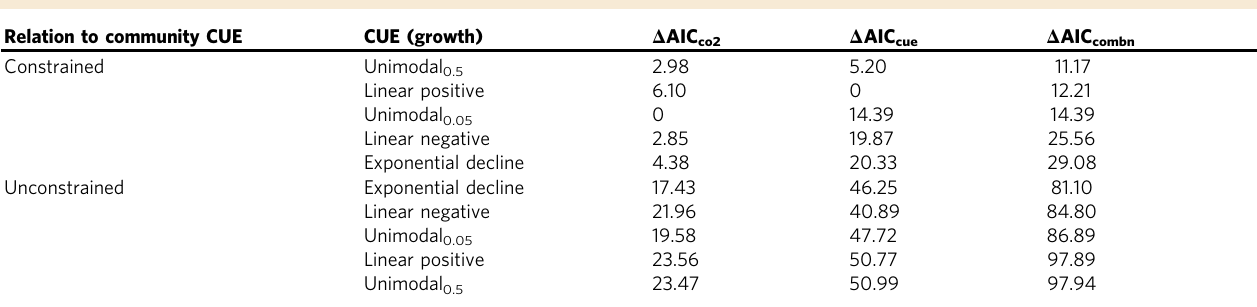
Table 1 Comparison of per-taxon carbon use ef fi ciency functions. Relation to community